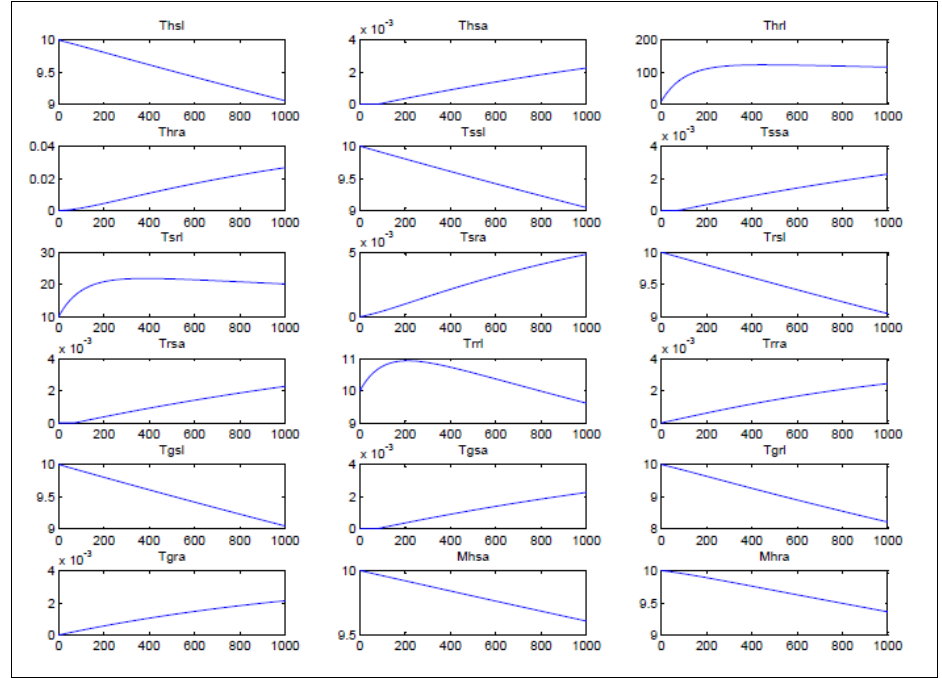
Figure 3. Infected cells dynamics (concave